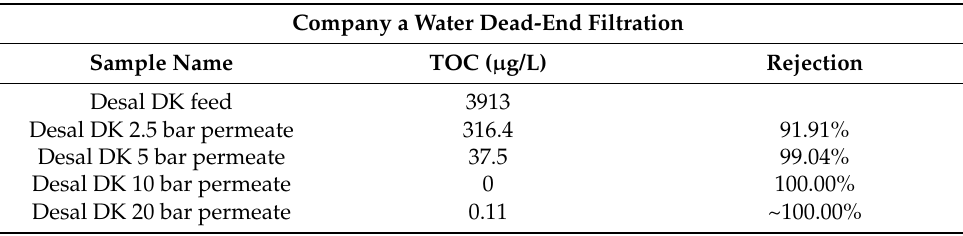
Table 5. TOC data for dead-end filtration of the Bedfordshire site